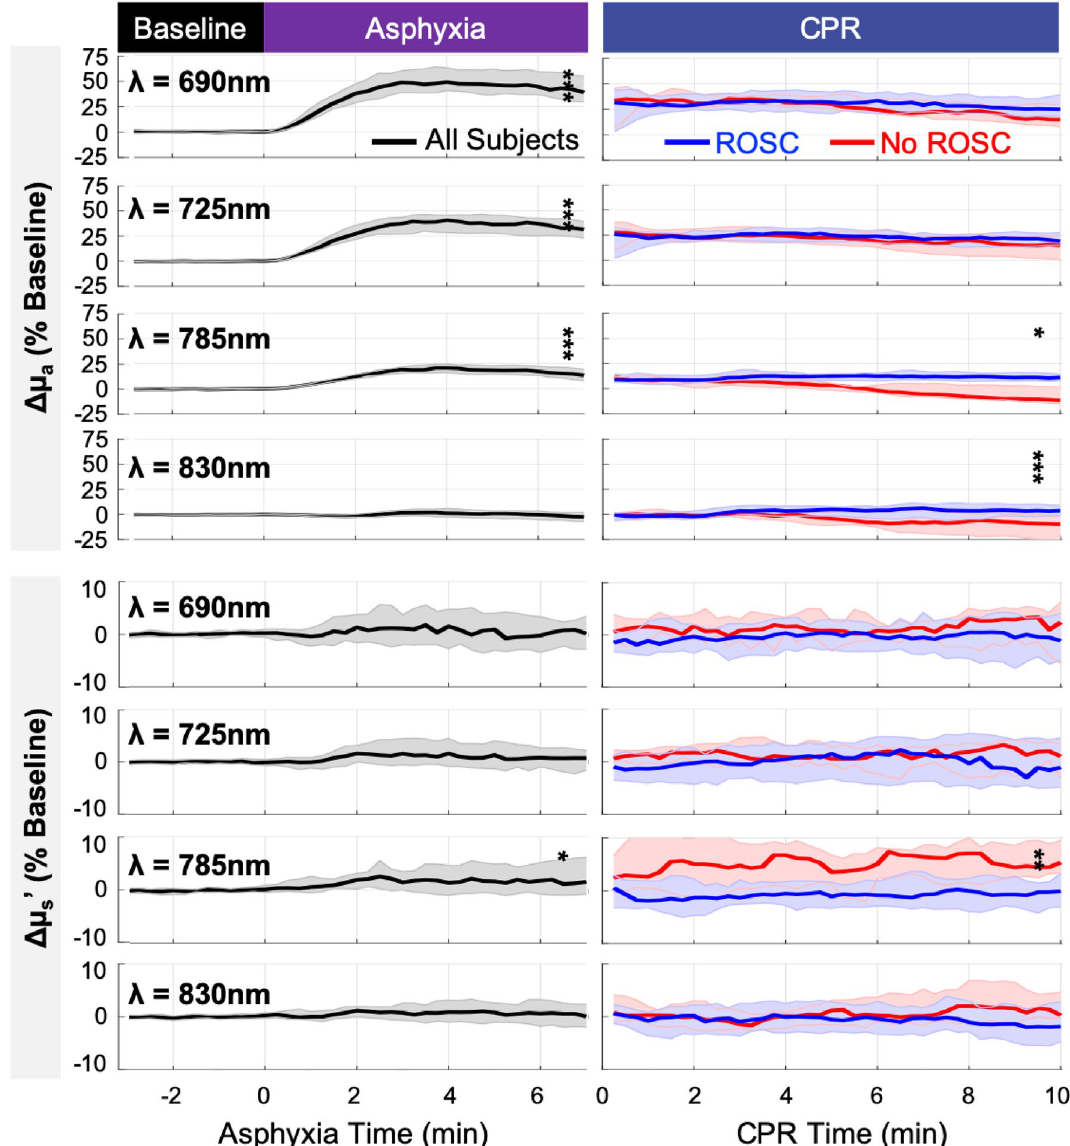
Figure 2. Changes in Optical Absorption (µ a ) and Scattering (µ s ′ ) Properties during Asphyxia ( left ) and CPR ( right ): Shown are the median ( thick line ) and interquartile range ( shaded ) of the measured changes during asphyxia (all subjects, black ) and during CPR (ROSC, blue ; No-ROSC, red ), expressed as a percentage (%) of baseline. Significant increases in µ a at 690, 725, and 785 nm and µ s ′ at 785 nm were observed at the end of asphyxia. In the 10th minute of CPR, the change in µ a at 785 and 830 nm from baseline was significantly greater in ROSC versus No-ROSC subjects, however change in µ s ′ at 785 nm was significantly greater in No-ROSC versus ROSC subjects (*, p < 0.05; **, p < 0.01; ***, p <